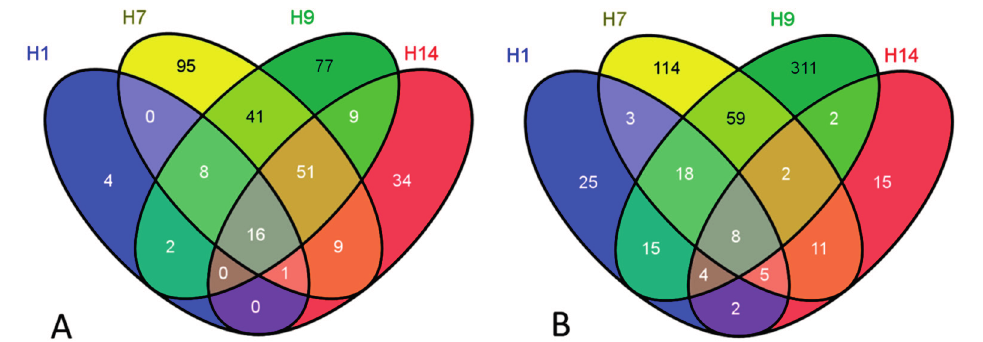
Figure 3. Venn diagrams of differentially expressed genes following HDIR exposures (16 h): ( A ) induced genes and ( B ) repressed